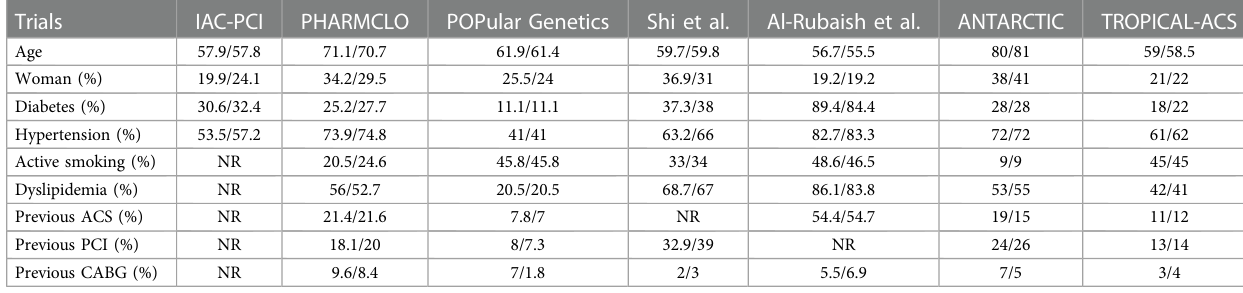
TABLE 2 Baseline characteristics of the patients included.